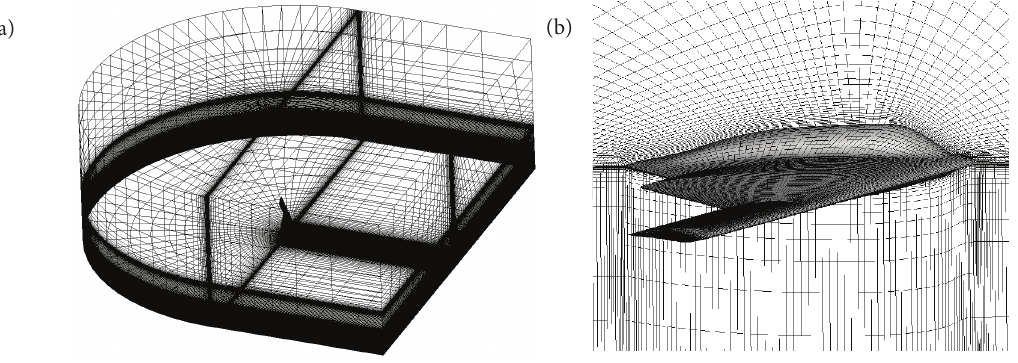
Figure 7. Computing grid. (a) C–H type grid ; (b) close view grid around